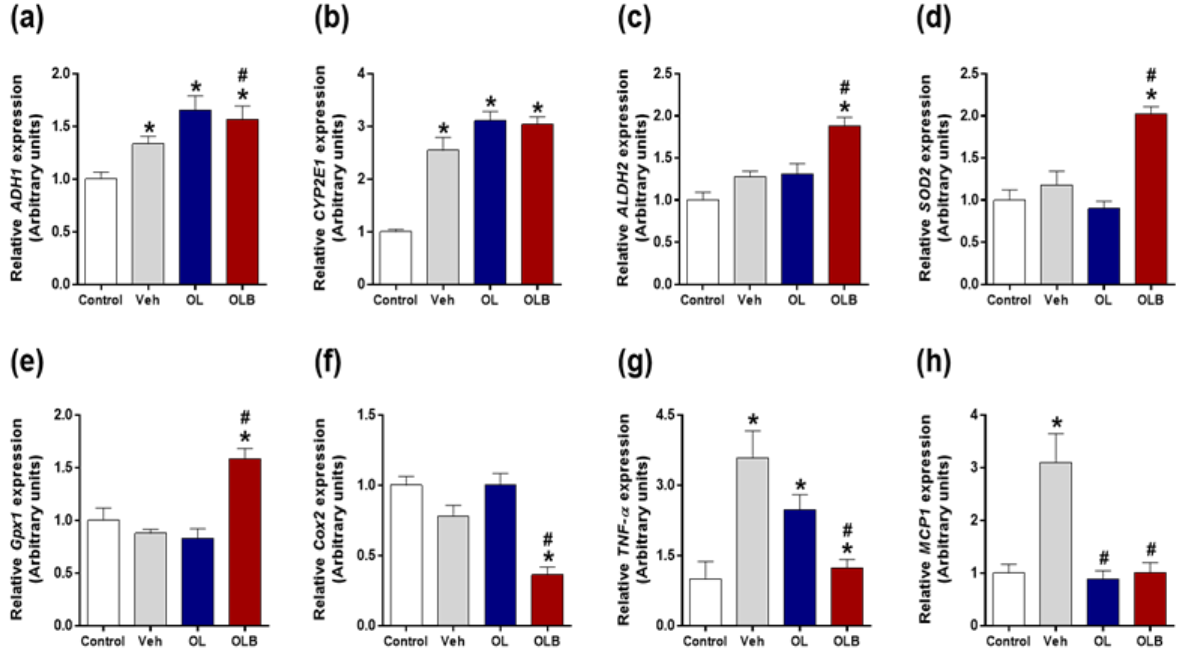
Figure 4. Quantitative real-time PCR analysis of ethanol metabolism–related and oxidative stress genes in the liver tissue of acute ethanol-induced mice. The mRNA levels of ADH1 ( a ), CYP2E1 ( b ), ALDH2 ( c ), SOD2 ( d ), Gpx1 ( e ), Cox2 ( f ), TNF- α ( g ), and MCP1 ( h ) in the liver are shown at 3 h after ethanol injection. Expression level was normalized to that of glyceraldehyde 3-phosphate dehydrogenase . Abbreviations: ADH1 , alcohol dehydrogenase 1 ; cytochrome p450 enzyme 2E1 , CYP2E1 ; ALDH2 , aldehyde dehydrogenase 2 ; SOD2 , superoxide dismutase 2 ; Gpx1 , glutathione peroxidase 1 ; Cox2 , cyclooxygenase 2; TNF- α , Tumor necrosis factor- α ; MCP1, Monocyte chemoattractant protein 1 . Values represent the means ± SEM ( n = 5 mice for each group). * p < 0.05 versus control, # p < 0.05 versus